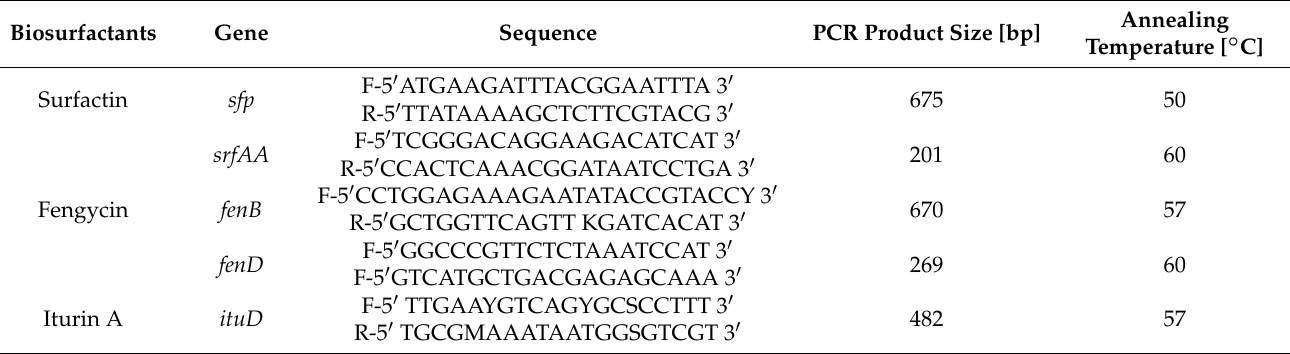
Table 3. The primers used to screen the genes responsible for BSs biosynthesis [30,77,78].